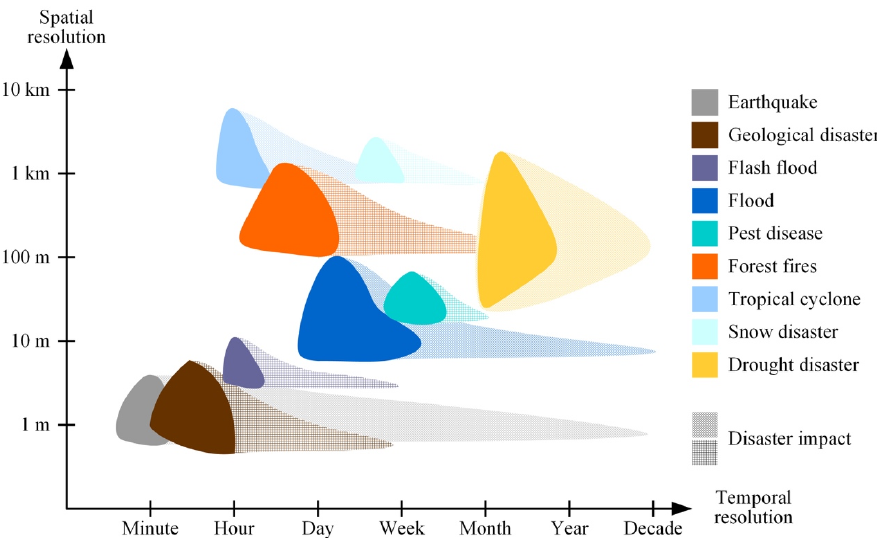
Figure 1. Spatial and temporal resolution requirements of remote sensing images in disaster reduction (taken from “Disaster Reduction Application System Feasibility Analysis Report of Small Satellite Constellation for Monitoring and Forecasting of Environment and Disaster, 2006, National Disaster Reduction Committee of China”).